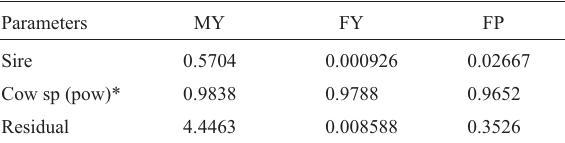
Table 3 - Covariance estimates of the random effects for milk yield (MY), fat yield (FY) and fat percentage (FP) for Holstein-Gir cows based on monthly test day data.